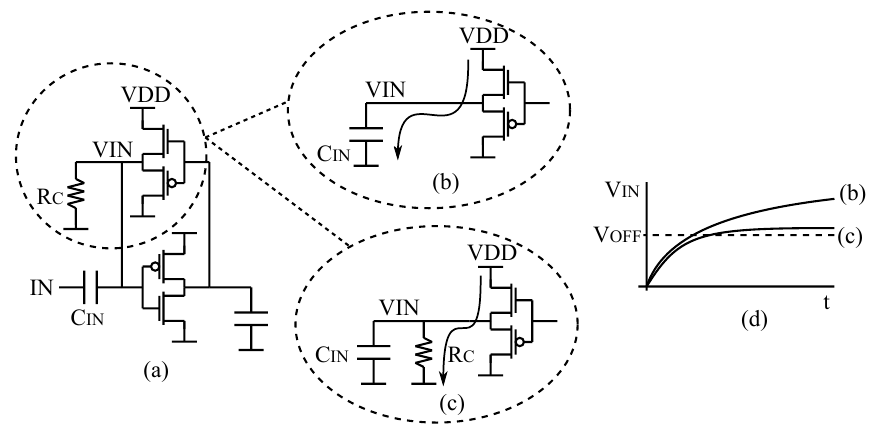
Figure 6. Offset compensation for low leakage PFGA. ( a ) PFGA with R C resistor. ( b ) Input node model without R C ( c ) Input node model with R C . ( d ) Comparison between the waveforms of Vin for the case ( b , c ).